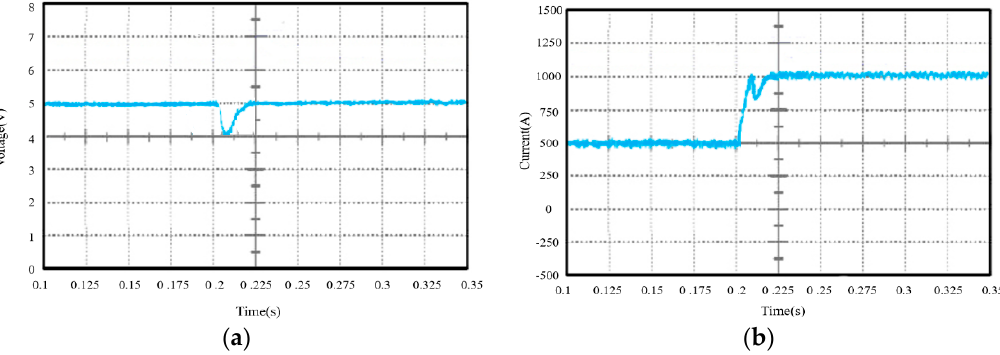
Figure 32. Load mutation experiment output waveform: ( a ) voltage experimental waveform under sudden load change, and ( b ) current experimental waveform under sudden load change.